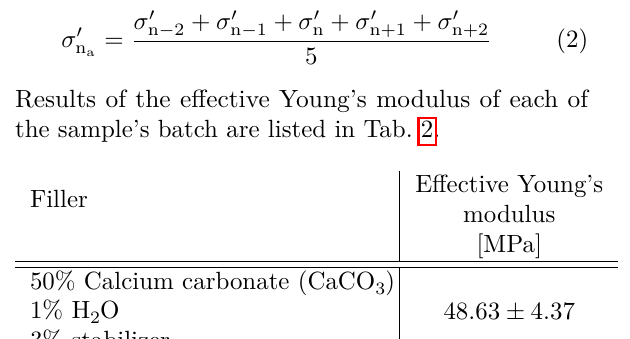
Figure 7. Stress-strain curves of no filler five values as: